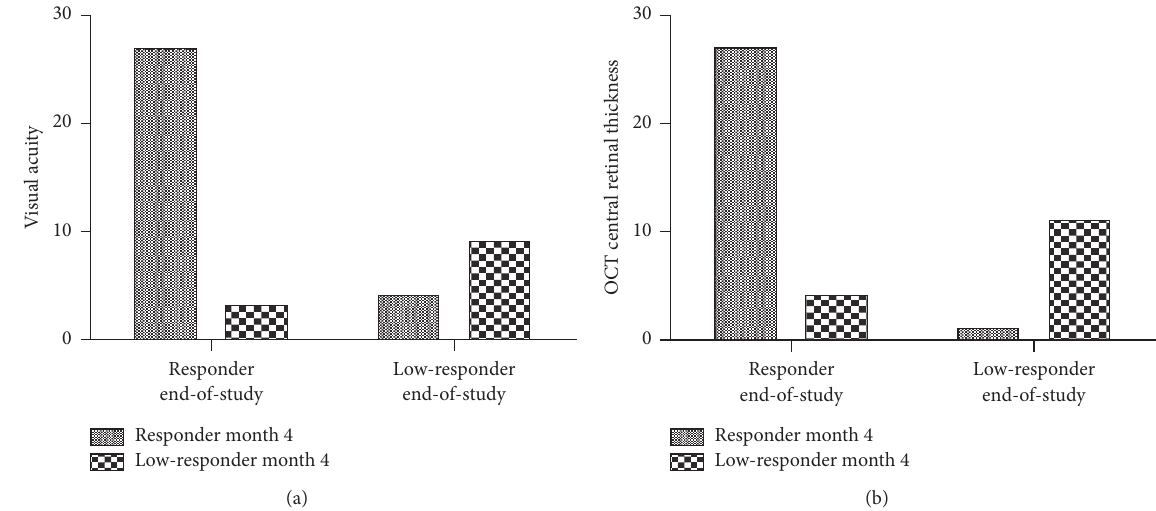
Figure 2: Distribution of responder and low-responder at different time points during the study in regard to visual acuity (a) and OCT central retinal thickness (b). The 𝑦 -axis represents the actual number of patients in each